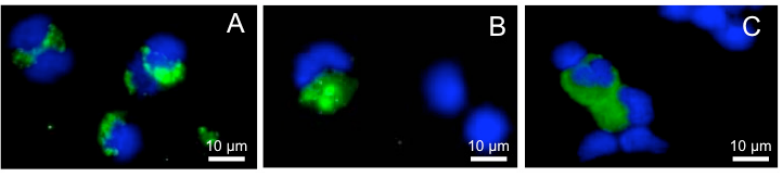
Figure 3. Comparison of Xenopus laevis tadpole and adult peritoneal macrophages infected by FV3. Peritoneal leukocytes were collected from one adult ( A ) or from 10 pooled pre-metamorphic tadpoles ( B and C ) 2 days after FV3 infection by intraperitoneal injection. Cells were fixed, stained with a rabbit anti-53R (green) and DNA dye Hoechst- 33258 (blue), then mounted in anti-fade medium and visualized with a Leica DMIRB inverted fluorescence